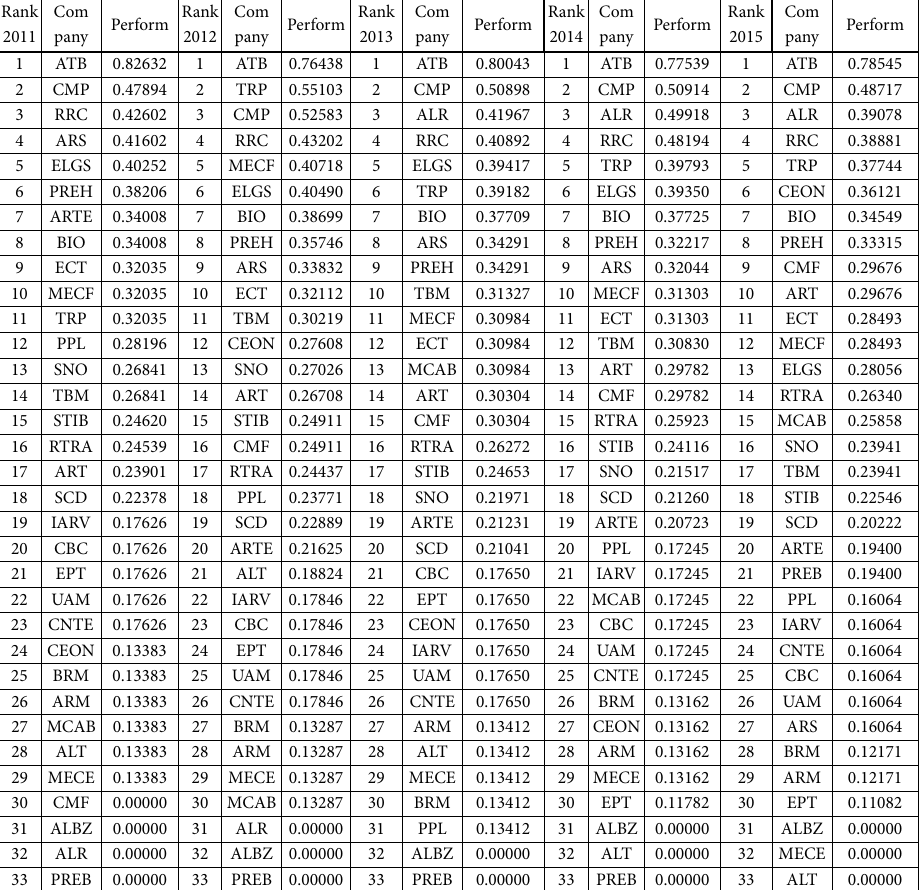
Table 11. Ranking of the companies in relation to all non-financial indicators